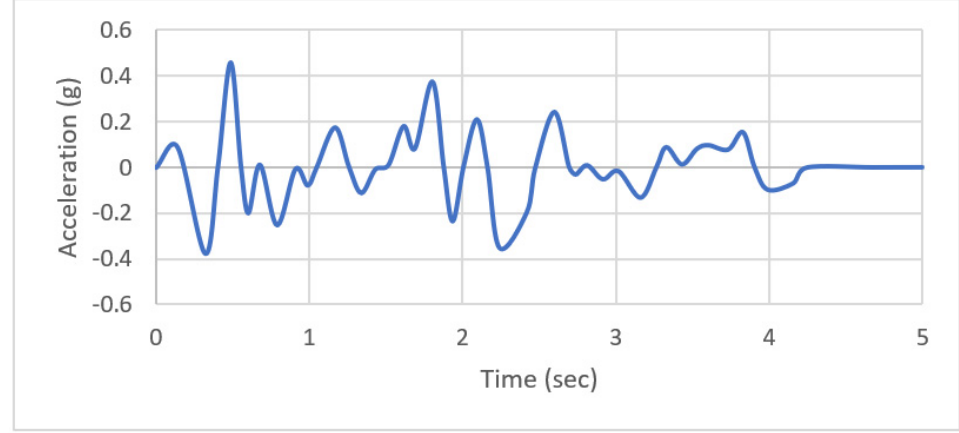
Figure 16. Ground Acceleration (Adapted from Ref. [14]).